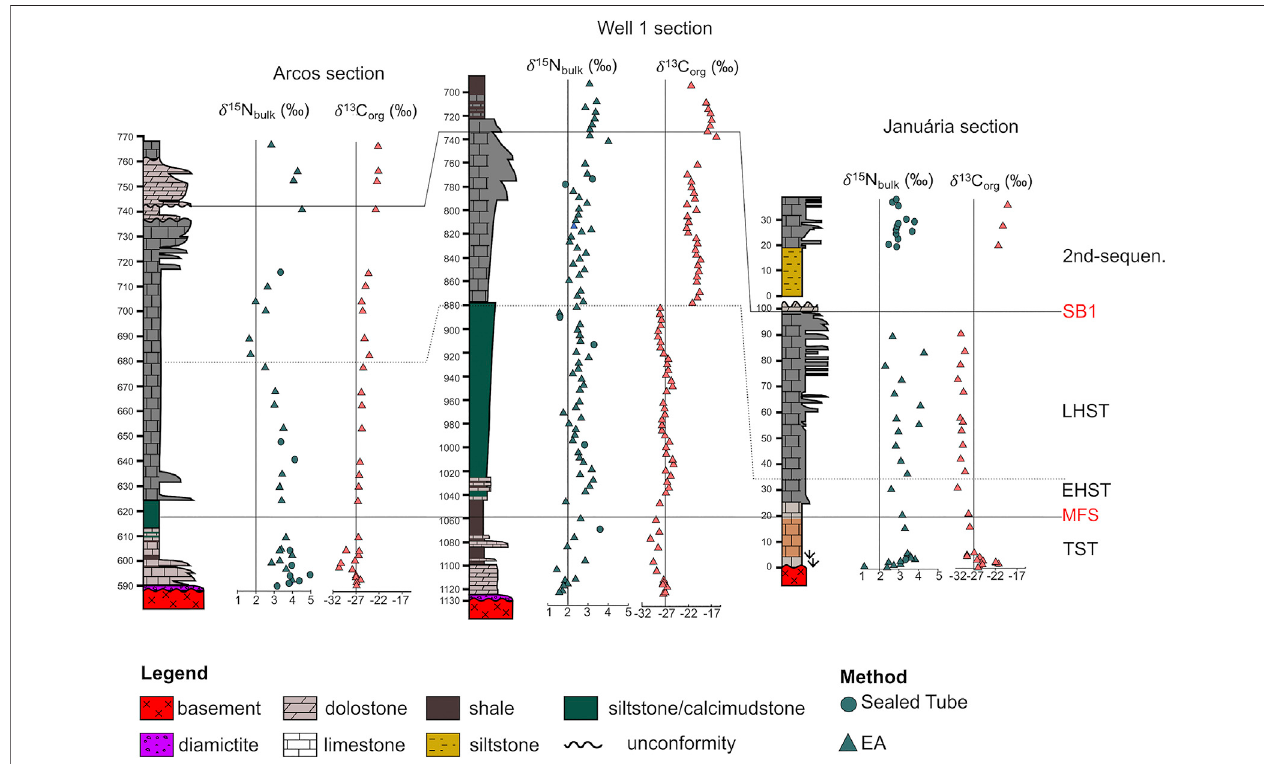
FIGURE 9 | Arcos, Well 1 and Janu (cid:1) aria stratigraphic correlation and their δ 15 N bulk and δ 13 C org data. δ 13 C org was published by Caetano-Filho et al. (2021).